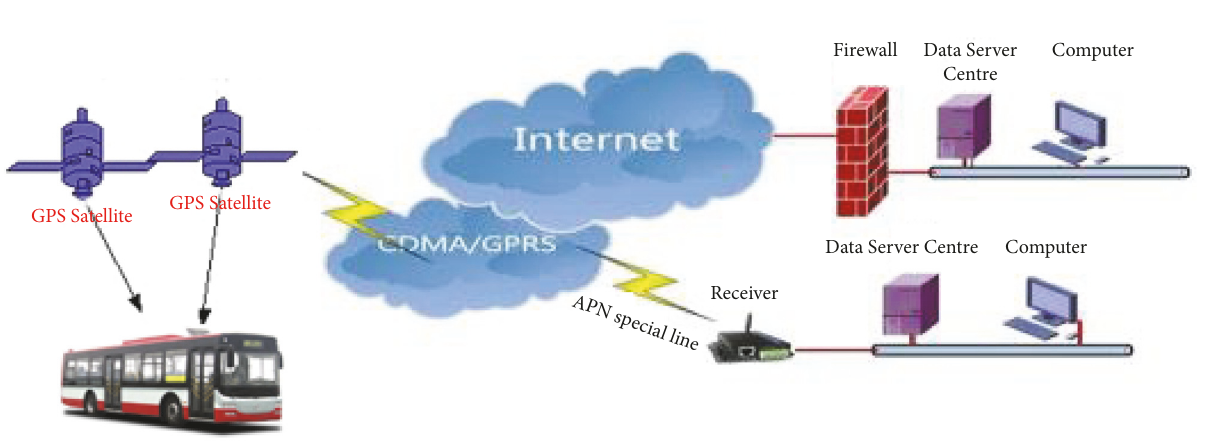
Figure 2: Schematic diagram of data acquisition process.